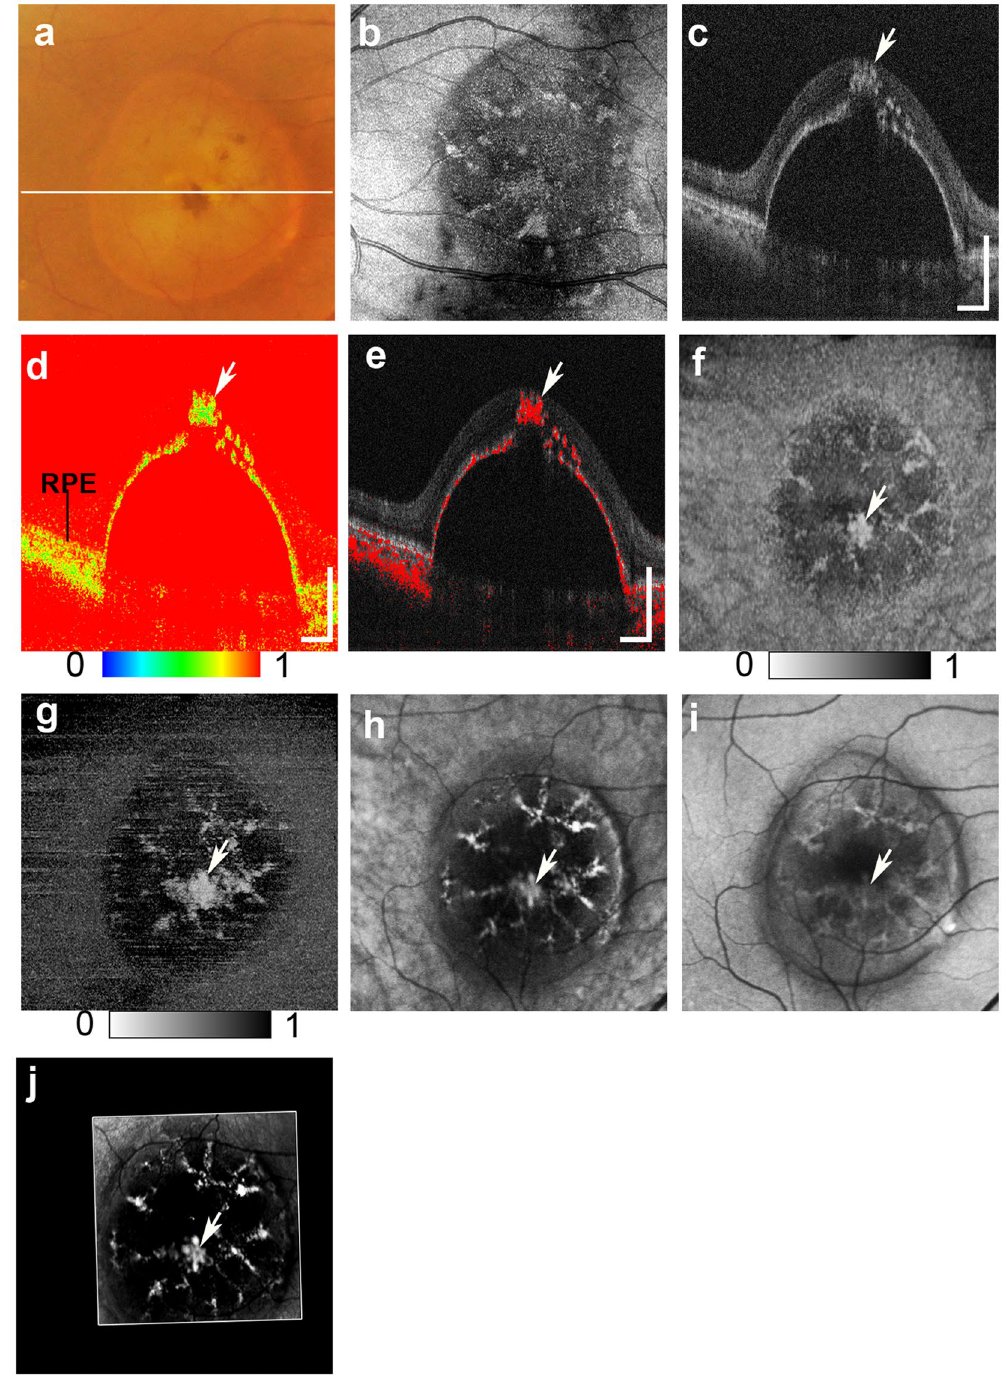
Figure 3. Multimodal imaging of serous PED from the right eye of a 70-year-old male. The white line in the color fundus photograph ( a ) indicates the scan line of the PS-OCT B-scan images ( c,d,e ). An en face projection of the standard OCT image ( b ). The standard OCT B-scan image ( c ) showing HRF (white arrow). A pseudocolor image of the DOPU B-scan image ( d ) and composite DOPU B-scan OCT images (e) showing depolarization at the HRF (white arrows). The scale bars represent 500 μ m × 500 μ m. An en face projection image of the minimum DOPU along the whole depth ( f ) and an en face projection of the minimum DOPU anterior to the RPE ( g ), which showed depolarization at corresponding locations of HRF (white arrows). NIR-AF image ( h ) and SW-AF image ( i ) show hyper-AF at corresponding locations of HRF (white arrows). A depolarized light image using the PS-SLO ( j ) shows depolarization at corresponding locations of HRF (white arrow). All abbreviation used are as defined in the figure legends for Figs 1 and